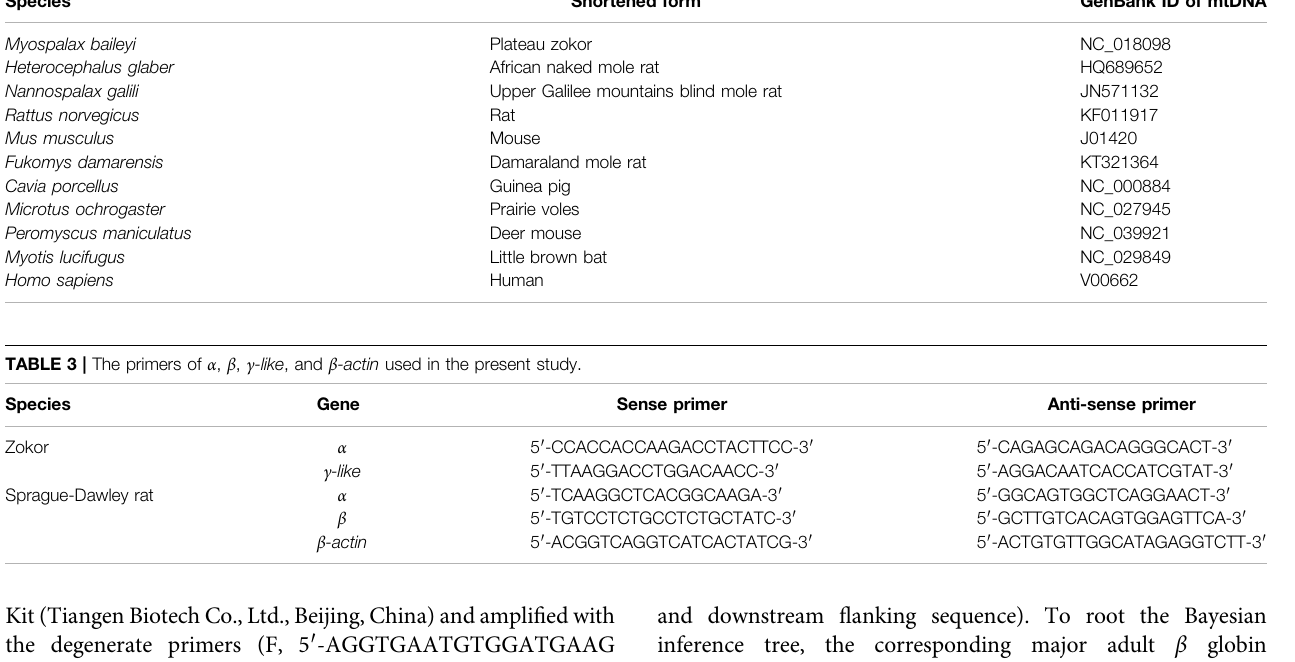
TABLE 2 | Names of 11 kinds of animals and their GenBank IDs of mtDNA. Species